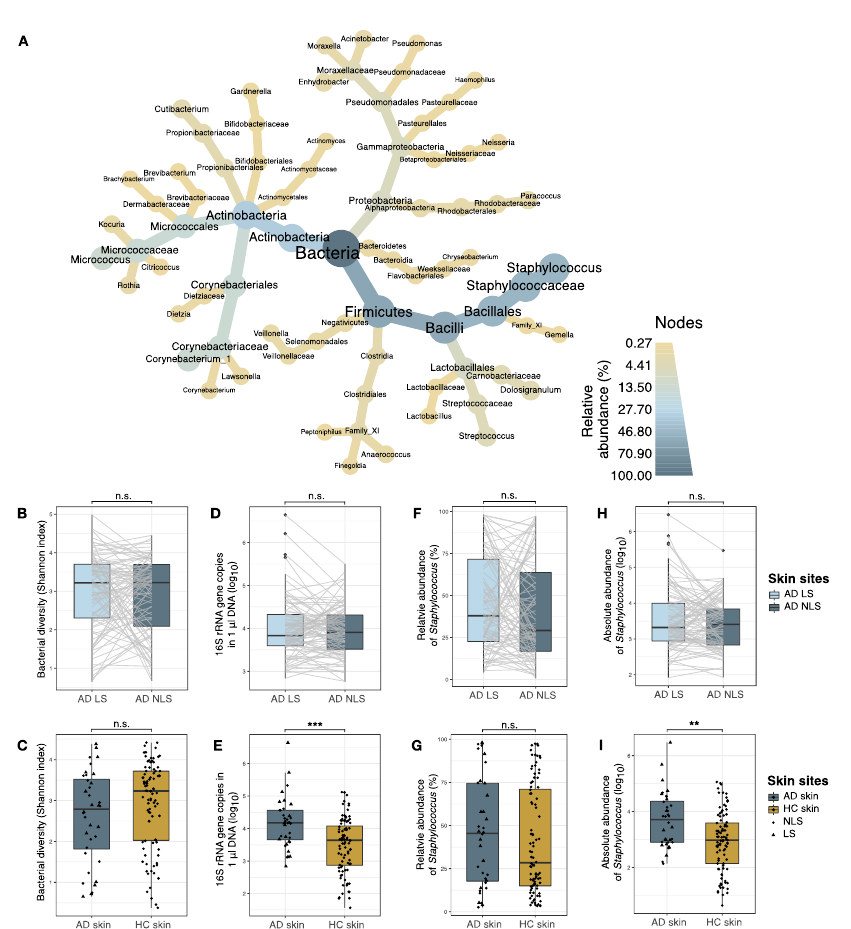
Figure 2. Skin bacterial communities. ( A ) Taxonomic illustration of the 30 most abundant genera on AD skin. Color and size of nodes and leaves correspond to the average relative abundance of taxa. AD lesional and non-lesional skin samples were grouped together. ( B , C ). Bacterial alpha diversity measured by Shannon index. ( D , E ) Absolute abundance of bacteria, measured as 16S rRNA gene copies within 1 µl DNA sample eluate. ( F , G ) Relative abundance (%) of Staphylococcus genus. Differences between skin sites were tested using ANCOM-BC modelling on log transformed sequence counts. ( H , I ) Absolute abundance of Staphylococcus , calculated by combining 16S rRNA qPCR and amplicon sequence data. In B , D , F , and H , lesional and non-lesional skin of AD patients ( n = 94) were compared. Samples collected from the same patient are indicated by grey lines. In C , E , G , and I , skin samples collected from AD patients ( n = 36) and healthy individuals ( n = 92) were compared. Here, AD lesional (triangles) and non-lesional (dots) skin samples were grouped together as AD skin. Boxplots represent the median and interquartile range (IQR) with whiskers extending to the minimum/maximum value, but no longer than 1.5xIQR. Asterisks indicate statistical significance: ** p < 0.01, *** p < 0.001, n .s.: not significant. Abbreviations: AD: atopic dermatitis; LS: lesional skin; NLS: non-lesional skin; HC: healthy control skin.